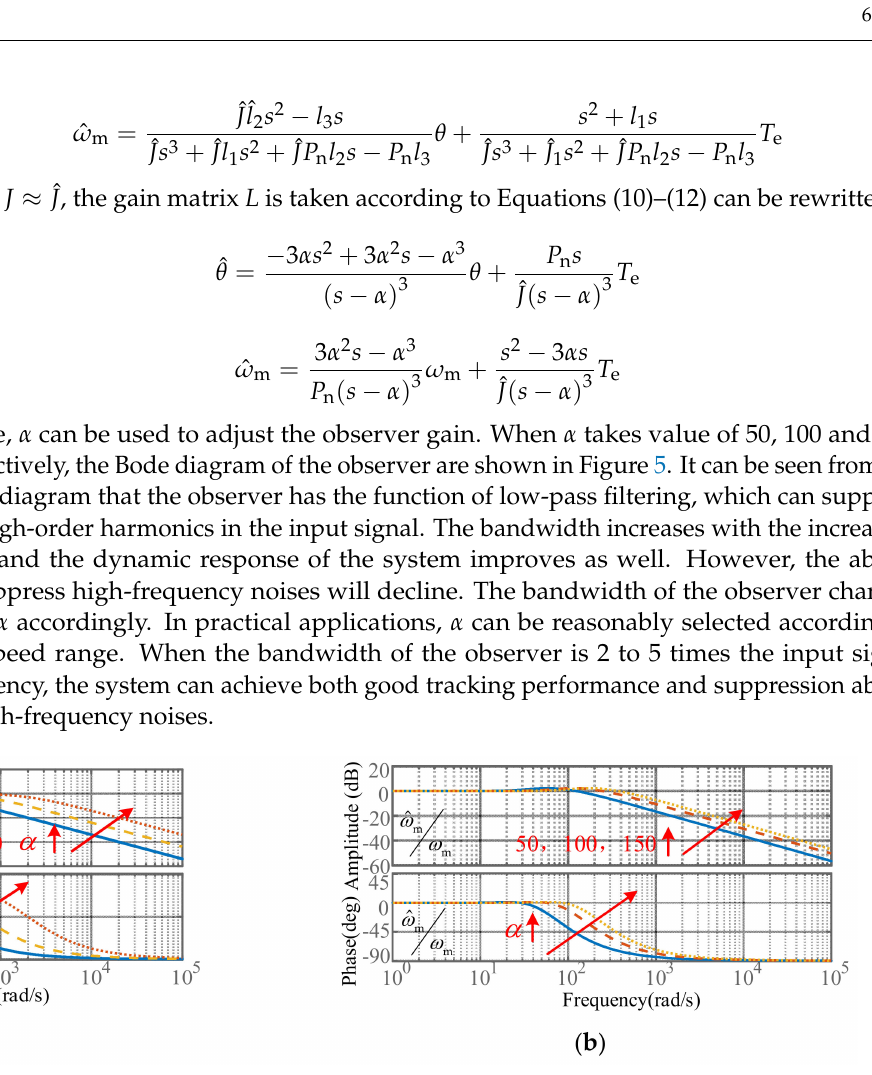
Figure 5. ( a ) Bode diagram of the observed position with different gain α ; ( b ) Bode diagram of the observed speed with different gain α